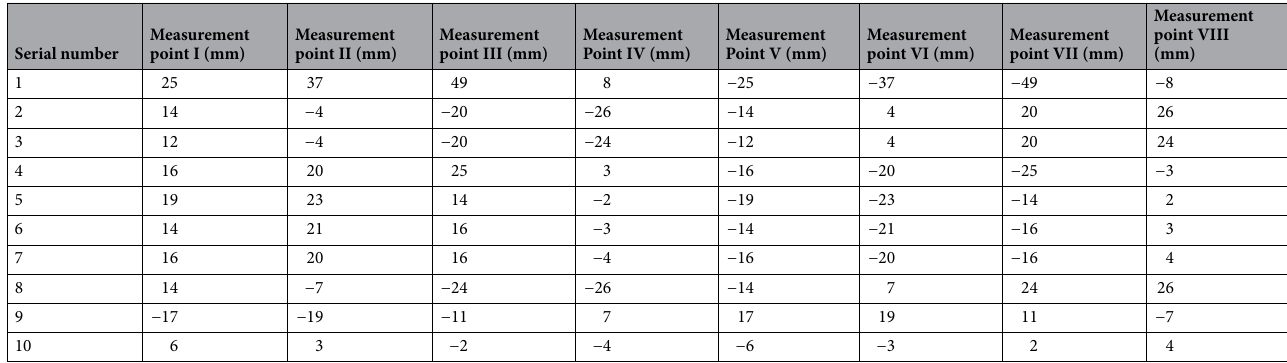
Table 1. Net total swing of measurement points (71–80 times).